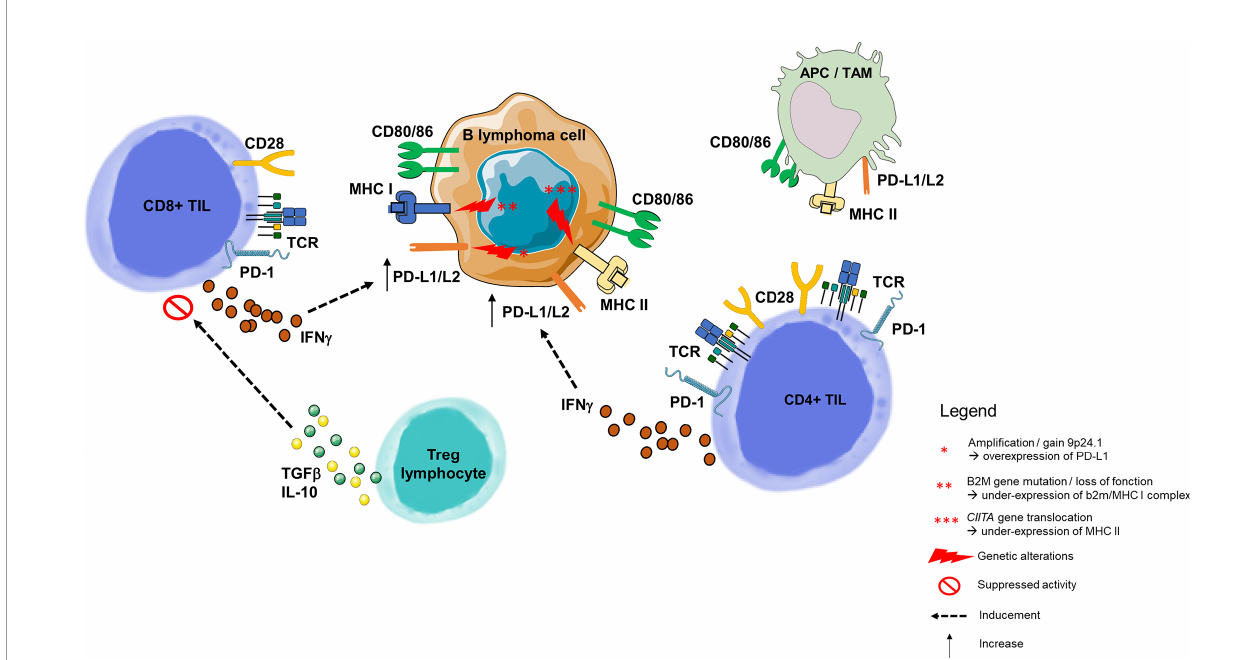
FIGURE 4 | Immune escape through PD-1/PD-L1 pathway in B-cell malignancies. As opposed to solid cancers, the malignant B lymphoma cell is also an immune cell, and its tumor microenvironment contains highly variable numbers of immune cells. B-cell malignancies arise in lymphoid tissues, and more precisely germinal center of lymph nodes (82). Molecular dissection of the malignant B-cell allows to understand the progressive behavior of different B-cell lymphoma subtypes. Among genetic alterations contributing to immune escape is the 9p24.1 copy gain or ampli fi cation, described many times in in fl ammatory lymphomas such as HL or Primary Mediastinal B Lymphoma (84), and correlated with overexpression of PD-L1 and PD-L2 on the surface of malignant cells (85). Two other mechanisms responsible for the malignant B lymphocyte inability to present tumor antigen to the CD8+ or CD4+ TLs are, respectively, loss of function of the gene encoding the b 2-microglobulin (MHC I complex dysfunction) (54, 86) and the dysfunction of CIITA (encoding MHC II) (87). PD-L1 is highly expressed on tumor-in fi ltrating macrophages and the surface of tumor cells and APCs in the tumor microenvironment (76). In a HL model, PD-L1+ macrophages were frequently in contact with PD-1 CD4+ TLs, suggesting that macrophages drive CD4+ TL dysfunction via PD-1/PD-L1 interactions, and/or by preventing direct access to Hodgkin Reed- Sternberg cells (88). Tumor cells upregulate PD-L1 to dampen cytotoxic TL attack. This upregulation is a consequence of pro-in fl ammatory cytokine production by tumor in fi ltrating immune cells: IFN g is produced by CD4+ and CD8+ TLs and acts as a potent PD-L1 upregulator (76). In a CLL model, Beyer et al. observed a signi fi cantly increased expression of TGF- b and IL-10 in Tregs from patients. Both cytokines play an important role for the CD8+ TL inhibitory function of these cells (89). For example, in FL, malignant cells guide differentiation of CD4+ TLs, skewing the population within the tumor towards Tregs. APC, Antigen Presenting Cell; HL, Hodgkin Lymphoma; IFN g , Interferon Gamma; IL-2, Interleukine 2; IL-10, Interleukine 10; MHC, Major Histocompatibility Complex; PD-1, Programmed Death 1; PD-L1, Programmed Death Ligand 1; PD-L2, Programmed Death Ligand 2; TAM, Tumor Associated Macrophage; TCR, T-cell Receptor; TGF- b , Transforming Growth Factor Beta; TIL, Tumor-in fi ltrating Lymphocyte; Treg, Regulatory T